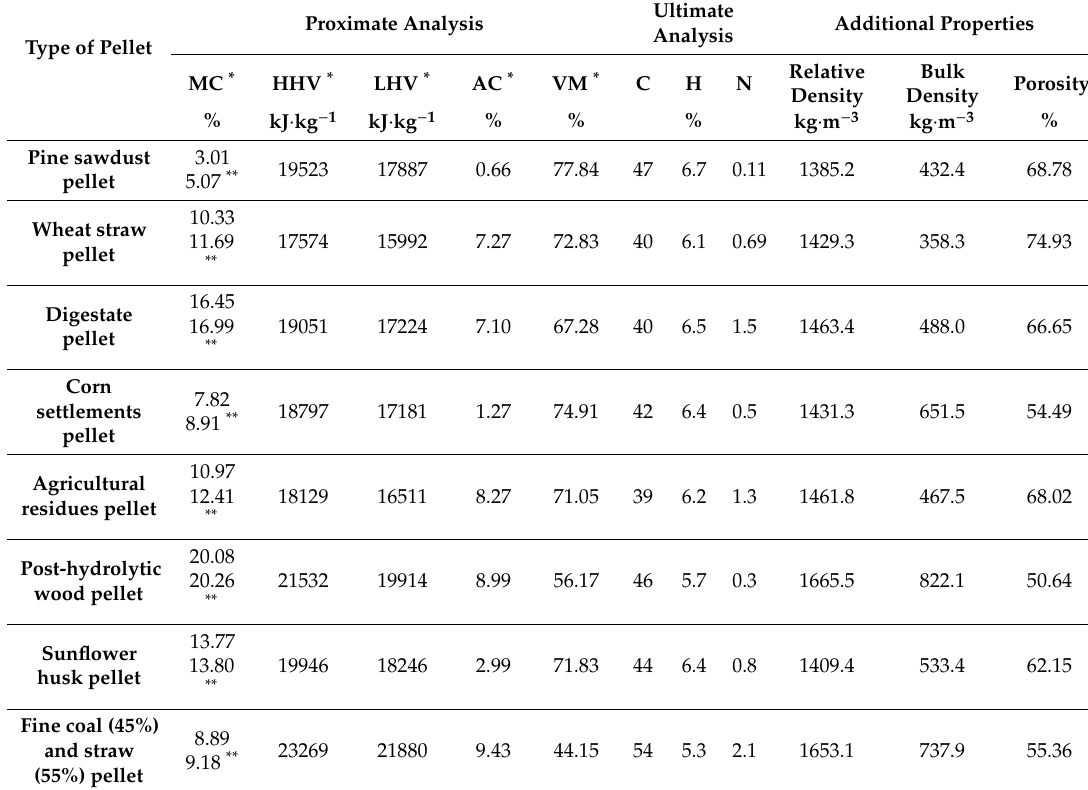
Table 1. Technical and physical analysis of commercial pellets